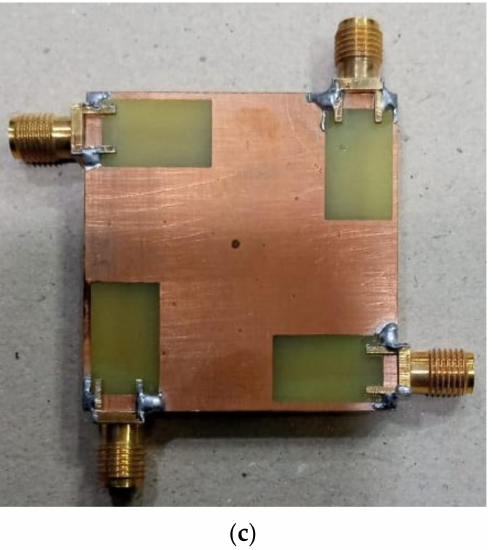
Figure 3. MIMO configuration: ( a ) simulated model, ( b ) fabricated prototype front, ( c ) back.